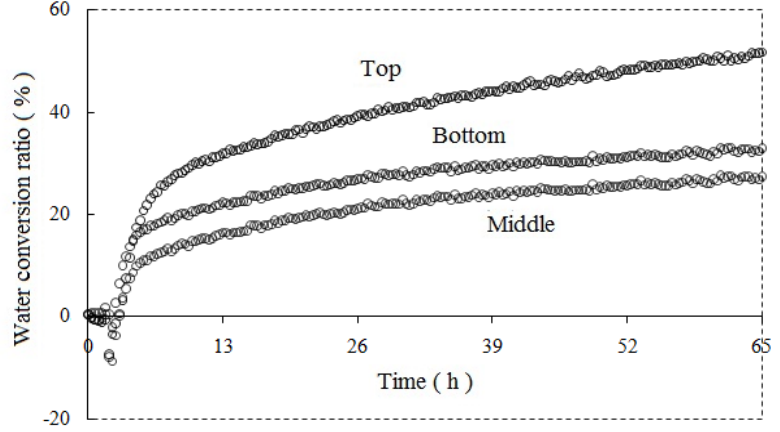
Figure 9. Water conversion ratio as a function of reaction time in loess.